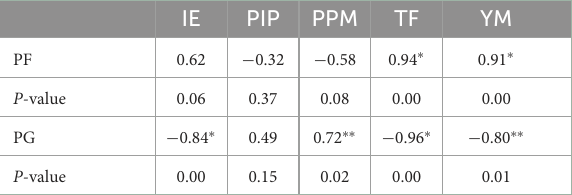
TABLE 7 Correlation coefficient of fat and fiber composition with physical and culinary properties of pasta based on hyperprotein